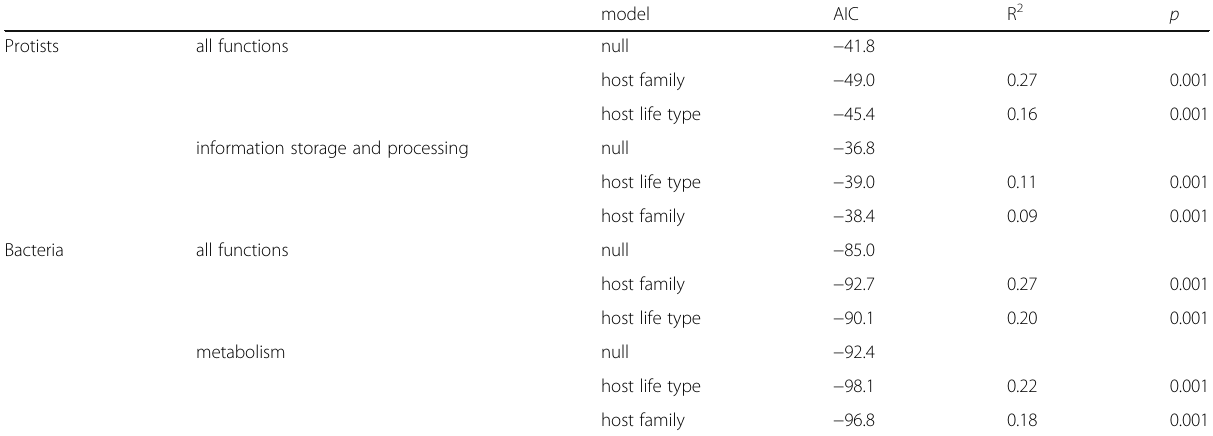
Table 1 Models of the effects of life type and host family (phylogeny) on functional community